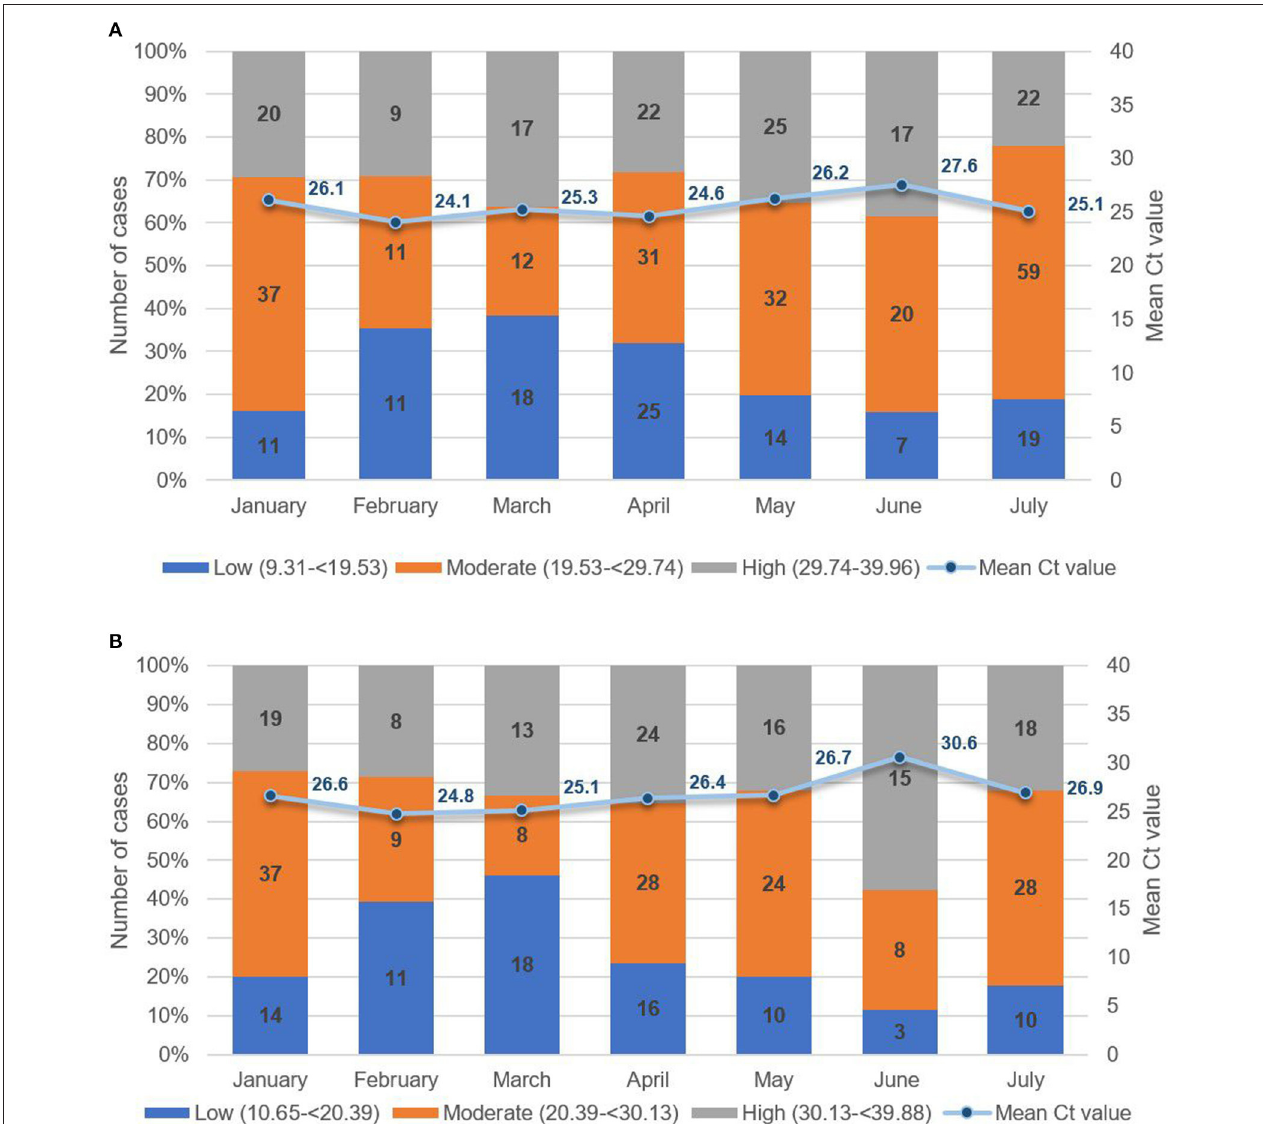
FIGURE 7 | (A) Mean Ct values of paediatric patients for ORF or RdRP target genes low (10.65 to < 20.39); moderate (20.39 to < 30.13); high (30.13 to 39.88). (B) Mean Ct values of paediatric patients for the N target gene low (9.31 to < 19.53); moderate (19.53 to < 29.74); high (29.74 to